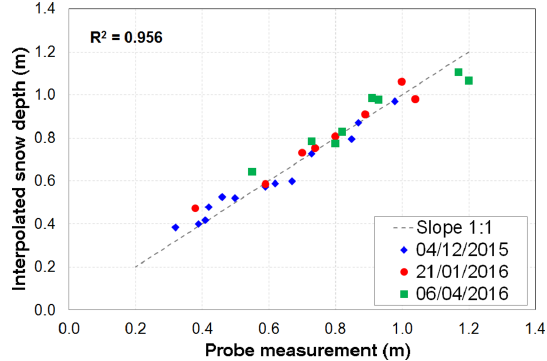
Figure B3. Interpolated snow depth from GPS method with respect to the hand made probe measurements for each observations session of ski slope. Average difference and RMS of the differences are detailed in Table